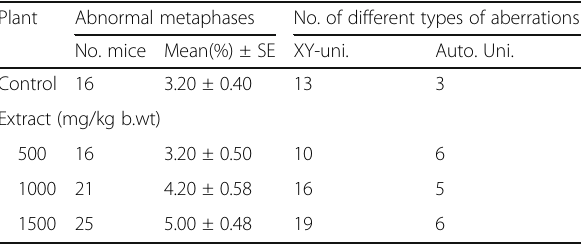
Table 3 Types and percentage of metaphases with spermatocyte cells chromosomal aberrations after plant treatment Plant